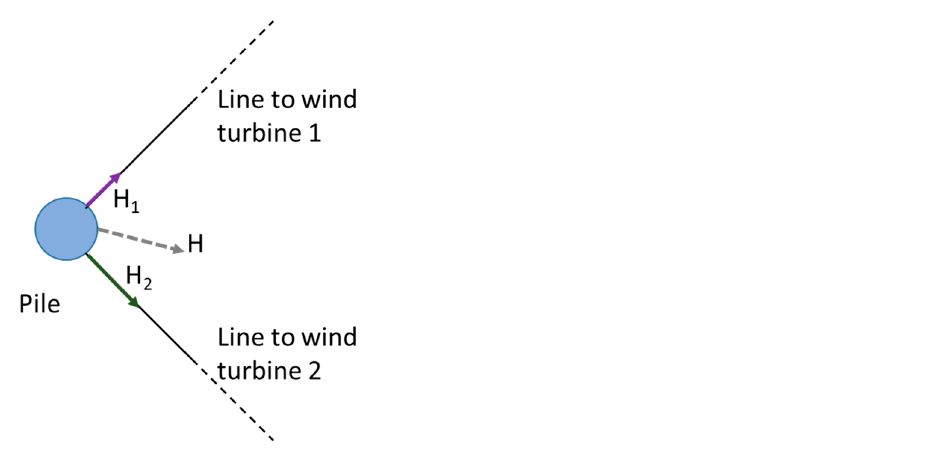
Figure 2. Concept of mutualized pile foundations for floating wind turbines (conceptual orientations).